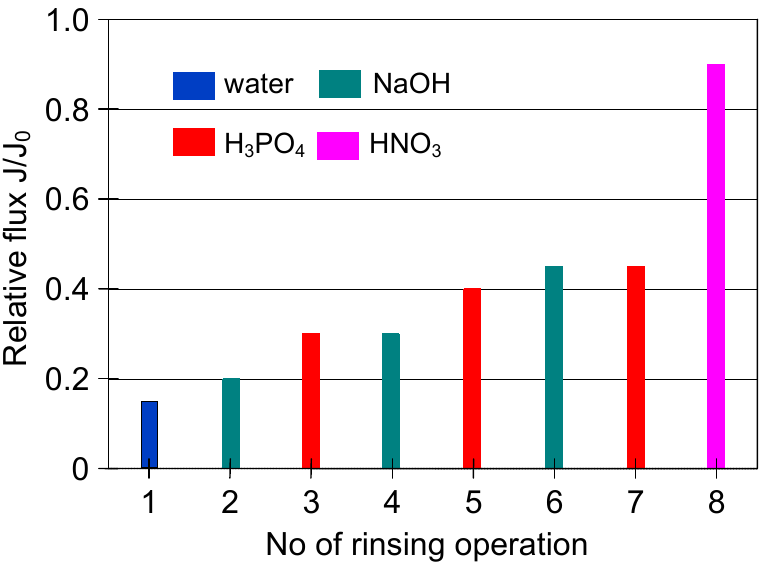
Figure 23. The efficiency of cleaning the ceramic membrane after the MF of yeast suspension (the first